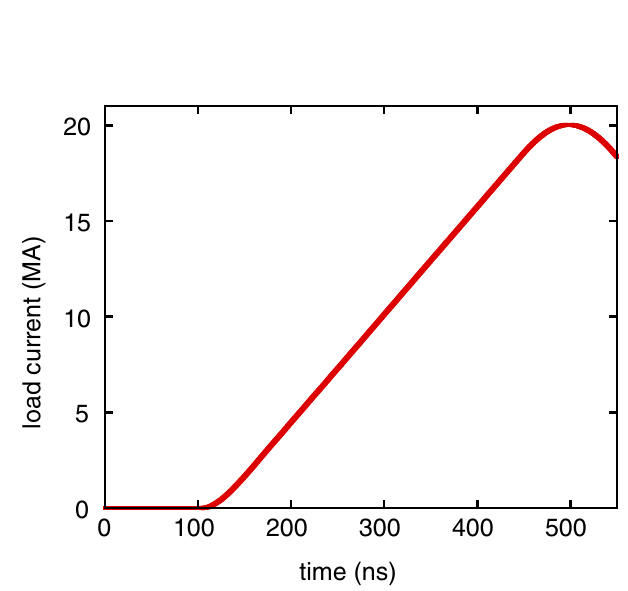
FIG. 8. Simulated load-current time history for a Neptune shot conducted with 600 Marx generators. The Marxes are triggered as required to achieve a 380-ns linear current ramp. The peak current is 20